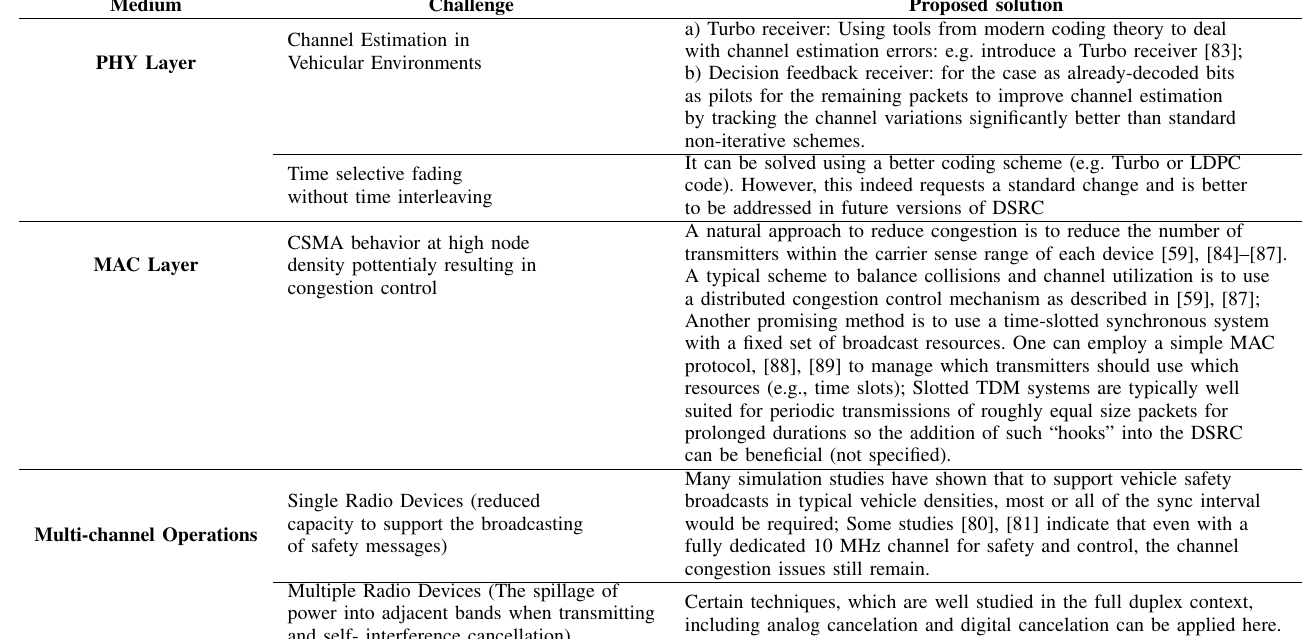
TABLE IV C HALLENGES AND SOLUTIONS FOR INTER - VEHICULAR COMMUNICATION . A DAPTED FROM